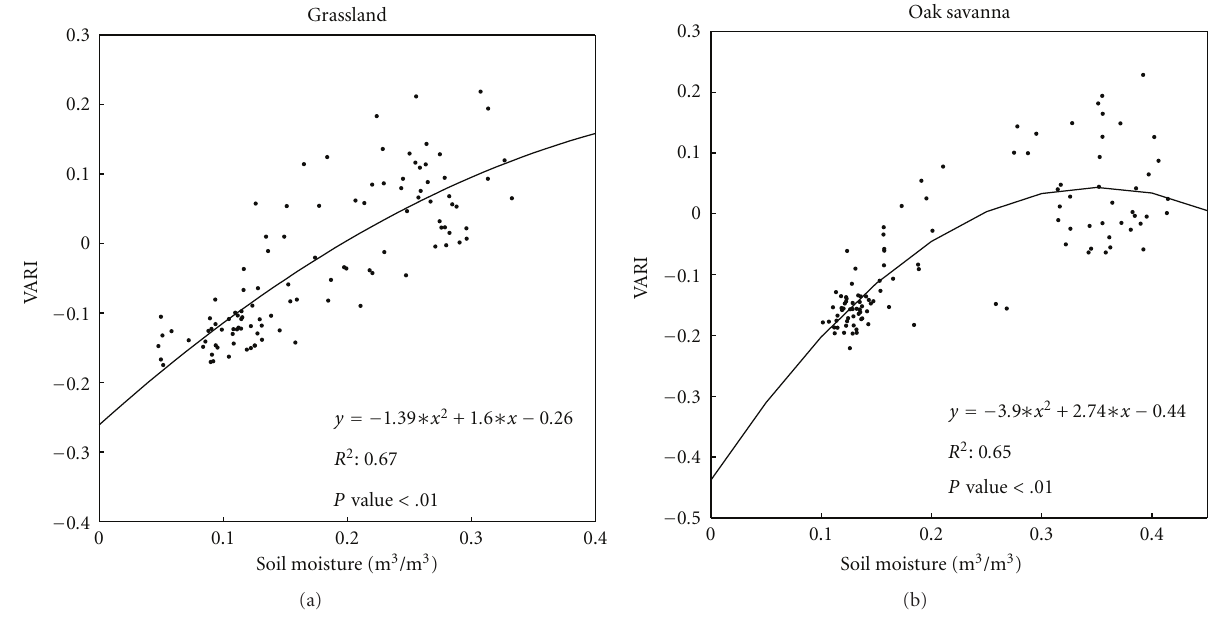
Figure 4: The relationship between VARI and averaged soil moisture at 10 cm in open grassland and averaged soil moisture at 20 cm in oak savanna during the same five-year measurement period.